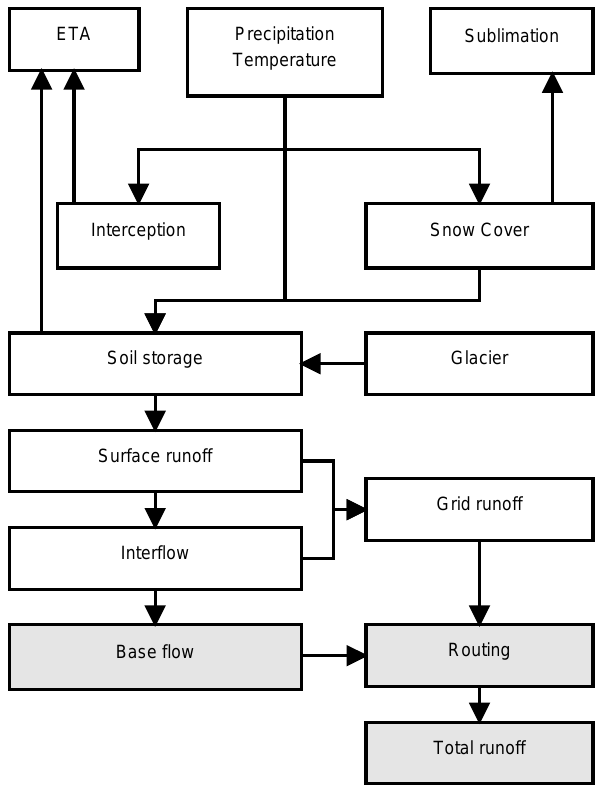
Figure 1. Flow chart of the conceptual model COSERO. White parts represent distributed processes, greyish parts are calculated on a subbasin scale. Snow transport is implemented in the snow cover module.